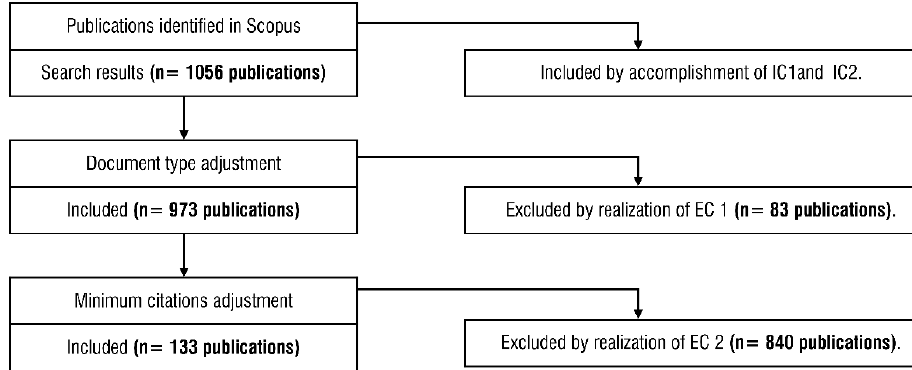
Figure 1. PRISMA flow chart of the procedure for selection of relevant publications.